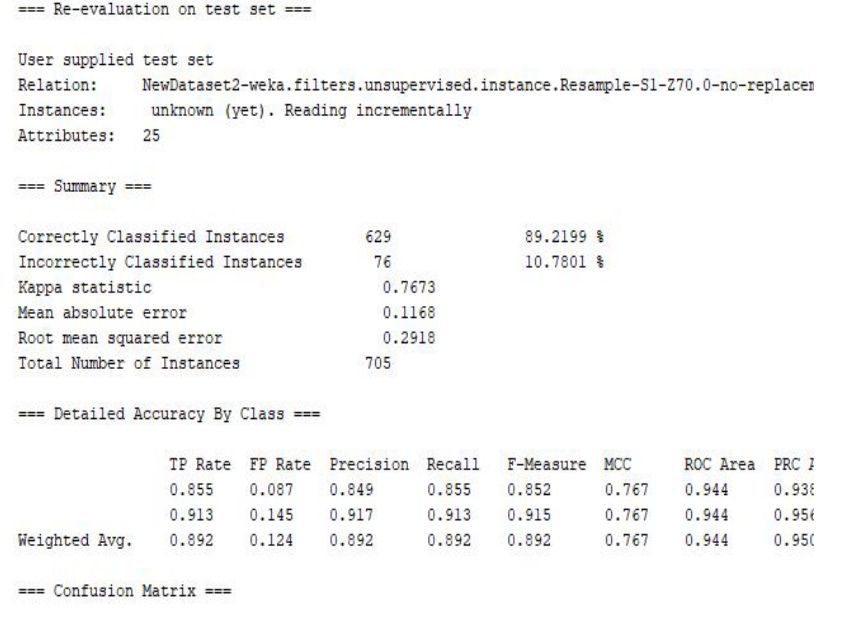
Figure 10: Naïve Bayes (NB) model for testing